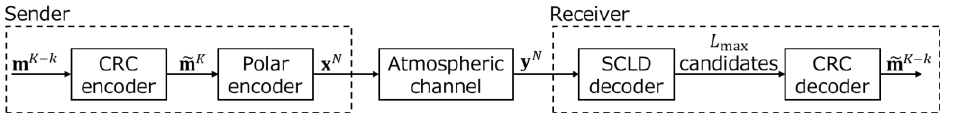
Figure 1. Block diagram of CA-SCLD polar-coded FSO transmission system.